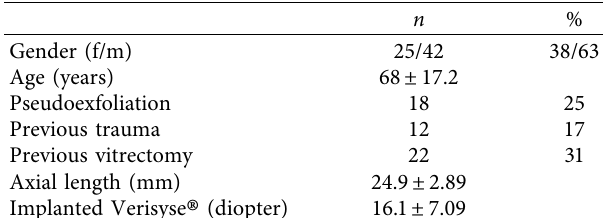
Figure 1: (a) Nine measuring points on the longitudinal axis shown for a haptic in the 3’o clock position. (b) Eight measuring points on the transversal axis shown for a haptic in the 3’o clock Table 1: Distribution of gender, age, axial length, and ocular diseases.